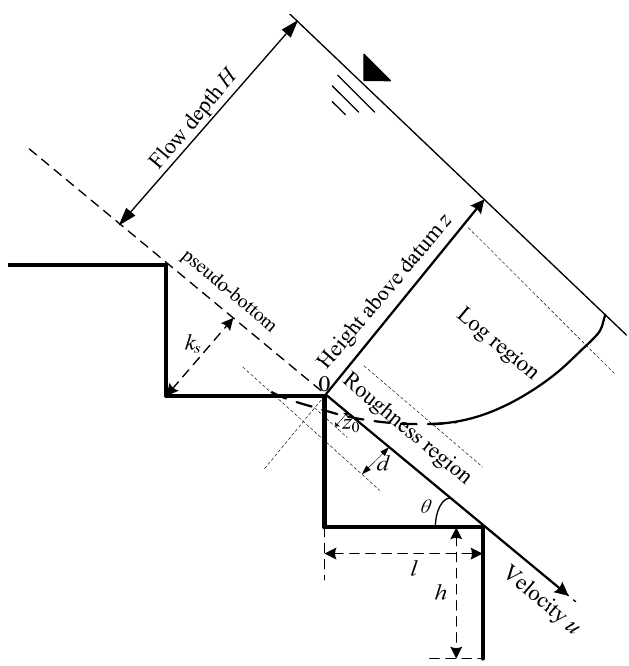
Figure 1. Illustration of velocity profile on stepped